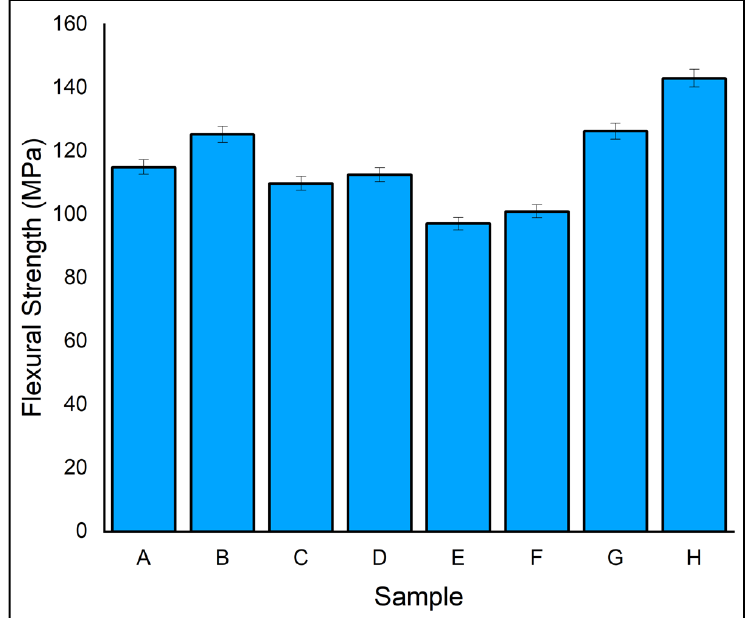
Figure 8. Flexural strength of specimen.